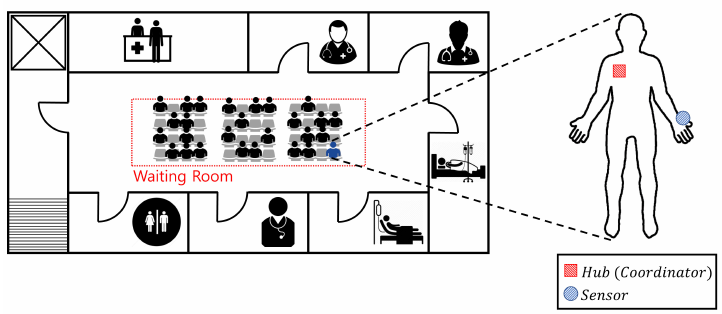
Figure 7. Network environment, assuming a hospital waiting